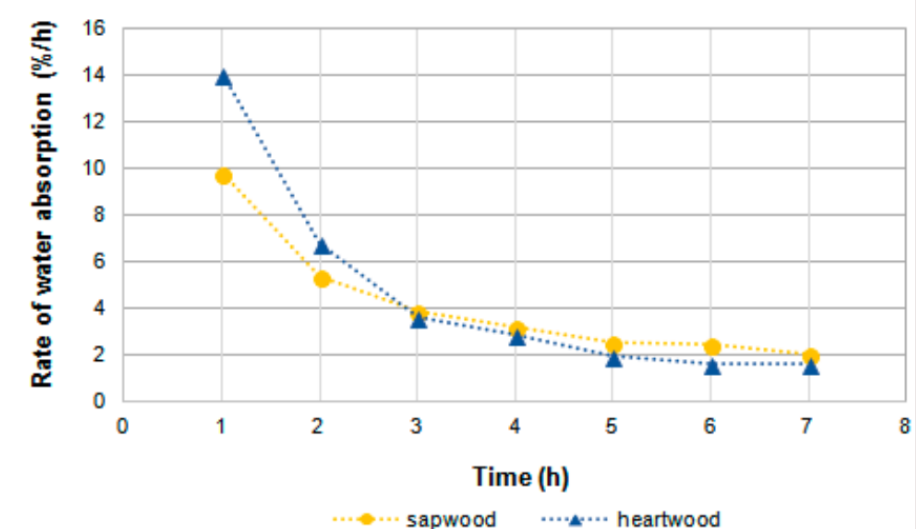
Figure 6. Rate of water absorption of oriental arborvitae wood.